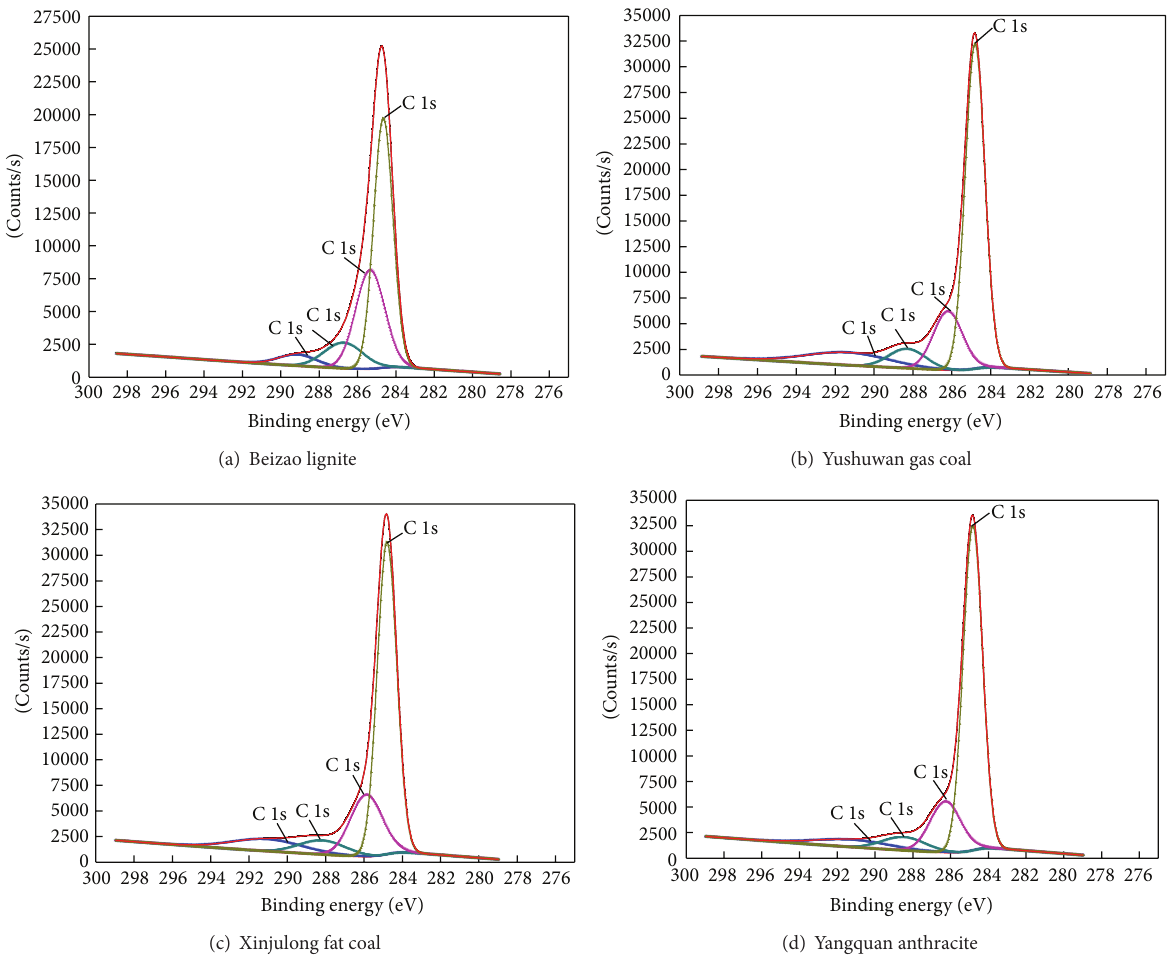
Figure 2: XPS peak chart of coal samples with different metamorphic grades. Table 2: Data of XPS full spectrum scan of coal samples with different metamorphic